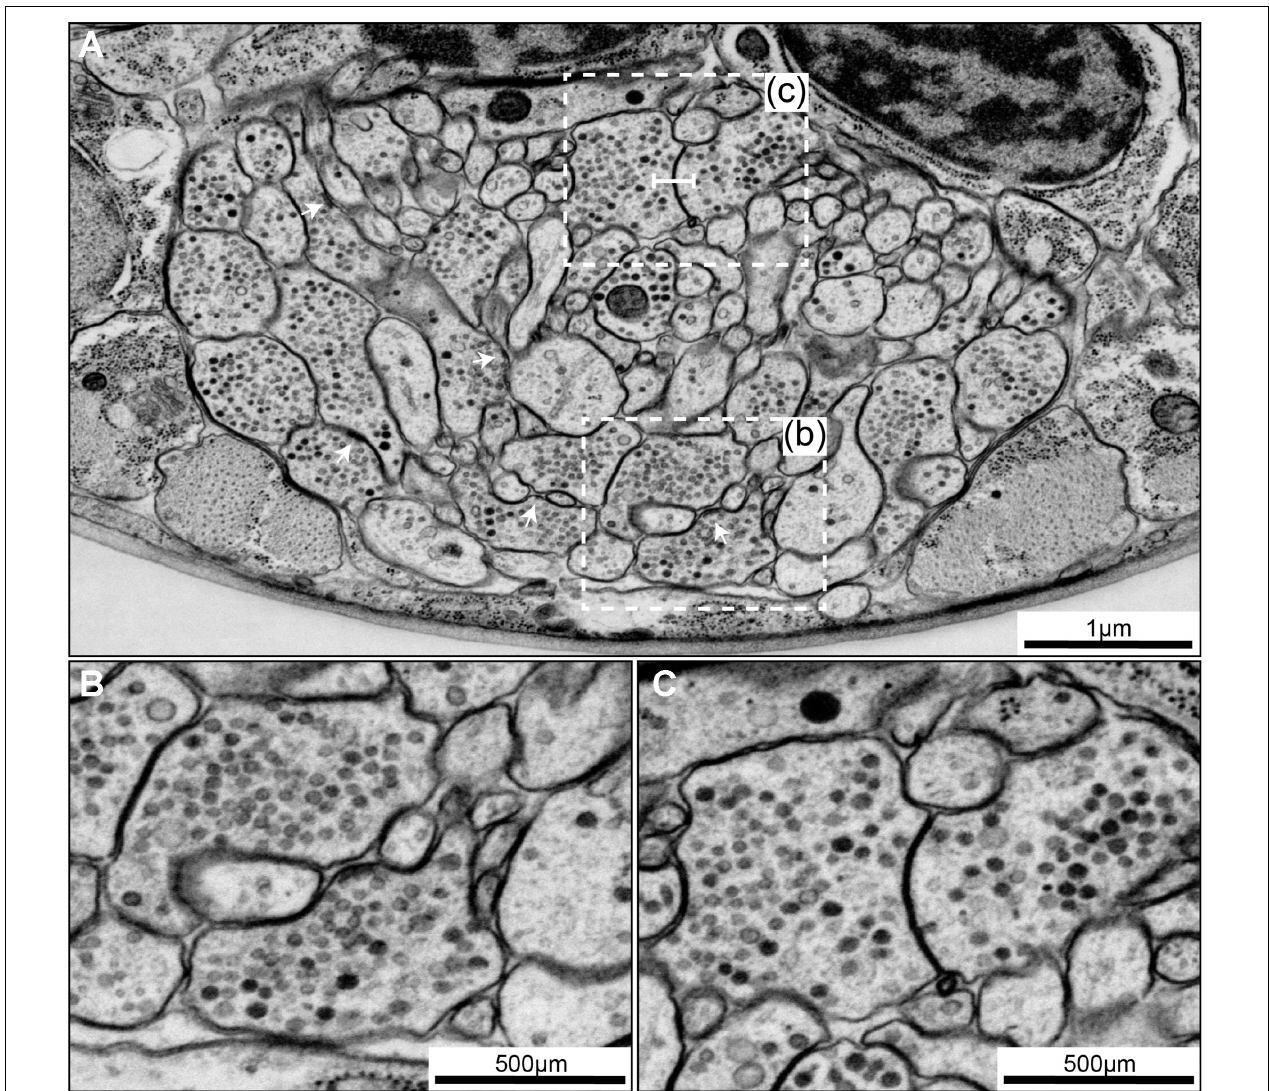
FIGURE 6 | Chemical synapses and gap junctions in C. elegans . (A) A section of the first larva (L1) ventral ganglion neuropil imaged using SEM at 1 nm/pixel. Multiple chemical synapses are visible (white arrows) as well as a gap junction (white flat-ended line). (B) Enlarged view of the chemical synapse highlighted with a dashed box in panel (A) . There is a presynaptic dense projection and a pool of synaptic vesicles, as well as some dense core vesicles further back in the neurite. This synapse is polyadic, releasing onto three neurons. (C) Enlarged view of the gap junction highlighted with a dashed box in panel (A) . There is a relatively flat area of close apposition between the